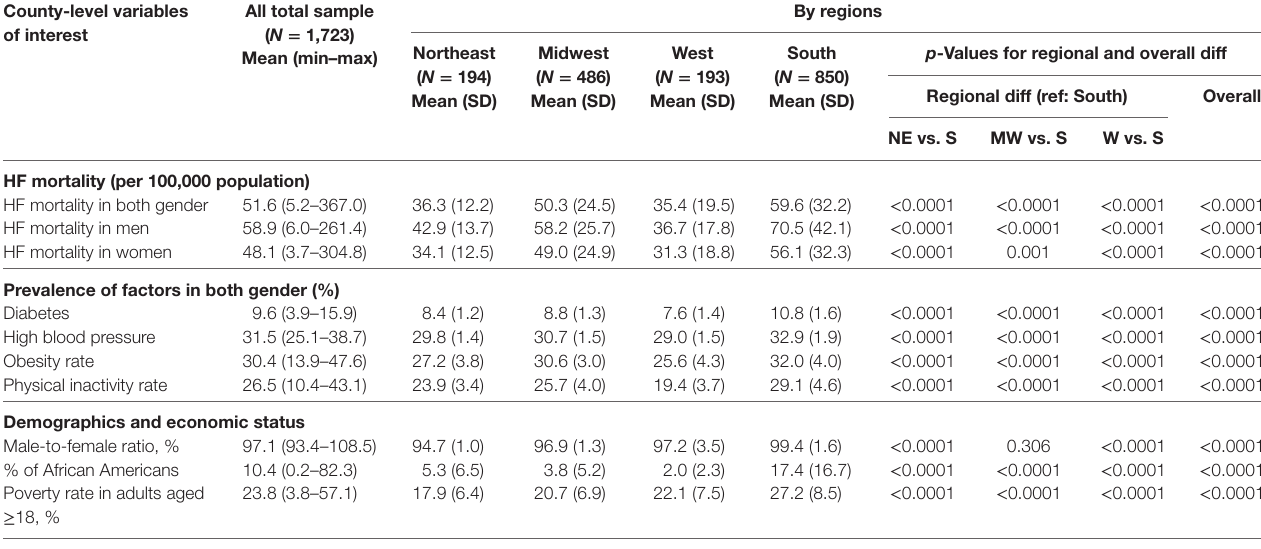
TaBle 1 | Characteristics of study population by regions. county-level variables of interest